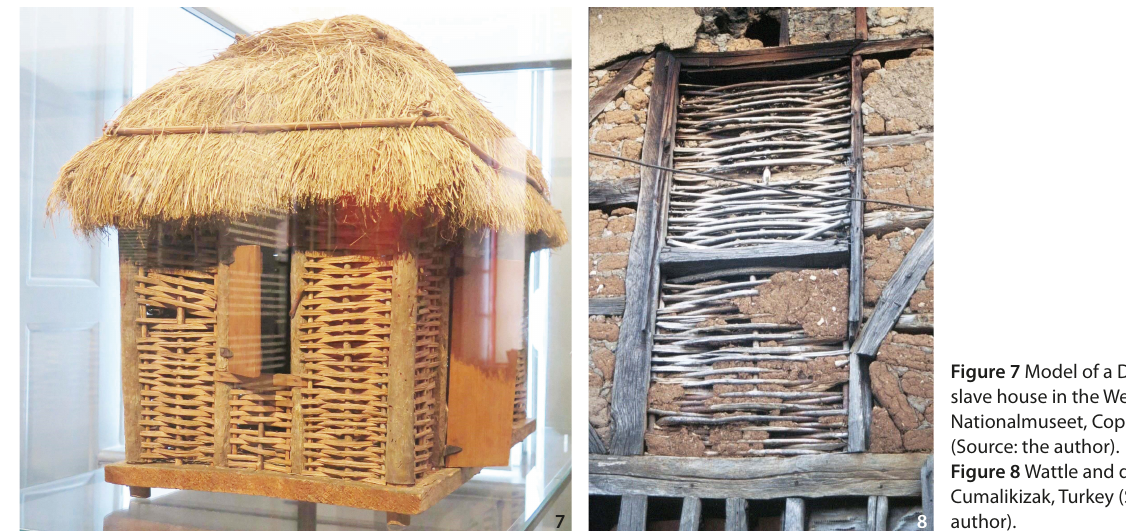
Figure 8 Wattle and daub